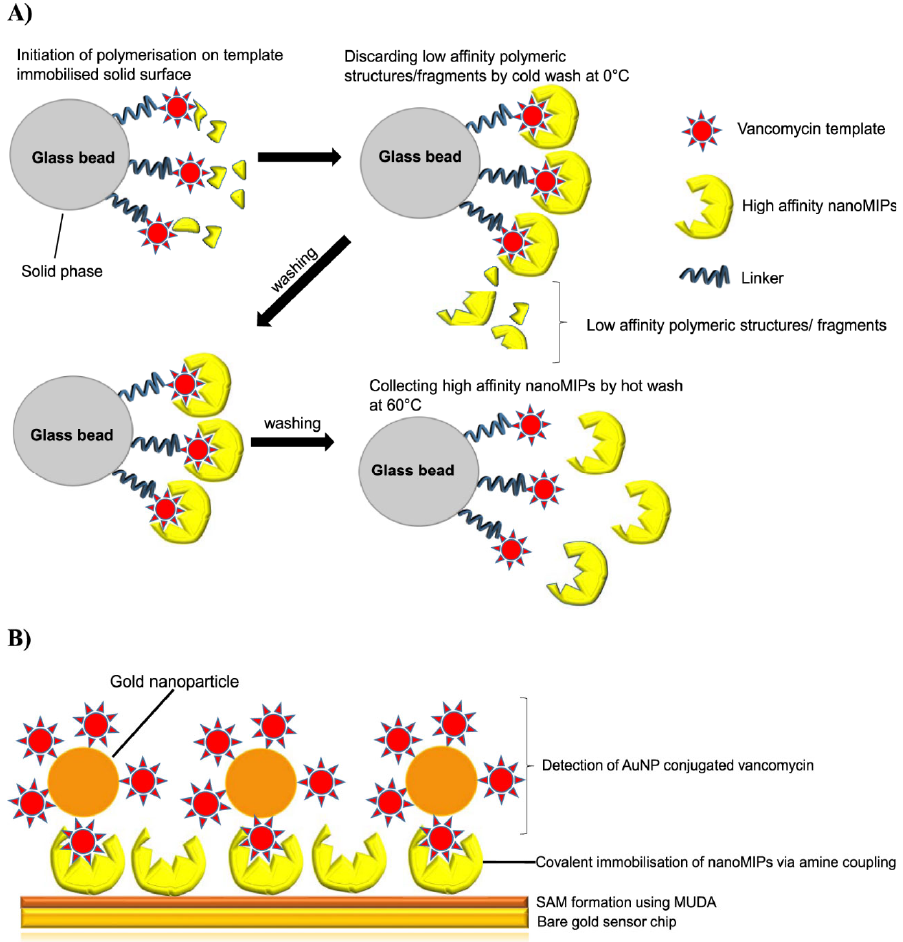
Figure 7. The efficient use of nanoMIPS for the detection of vancomycin, a glycopeptide antibiotic in milk samples. Insert ( A , B ) illustrates a schematic of the synthesis of vancomycin nanoMIPs and their chemosensing applications for the detection of vancomycin in complex matrices [103].